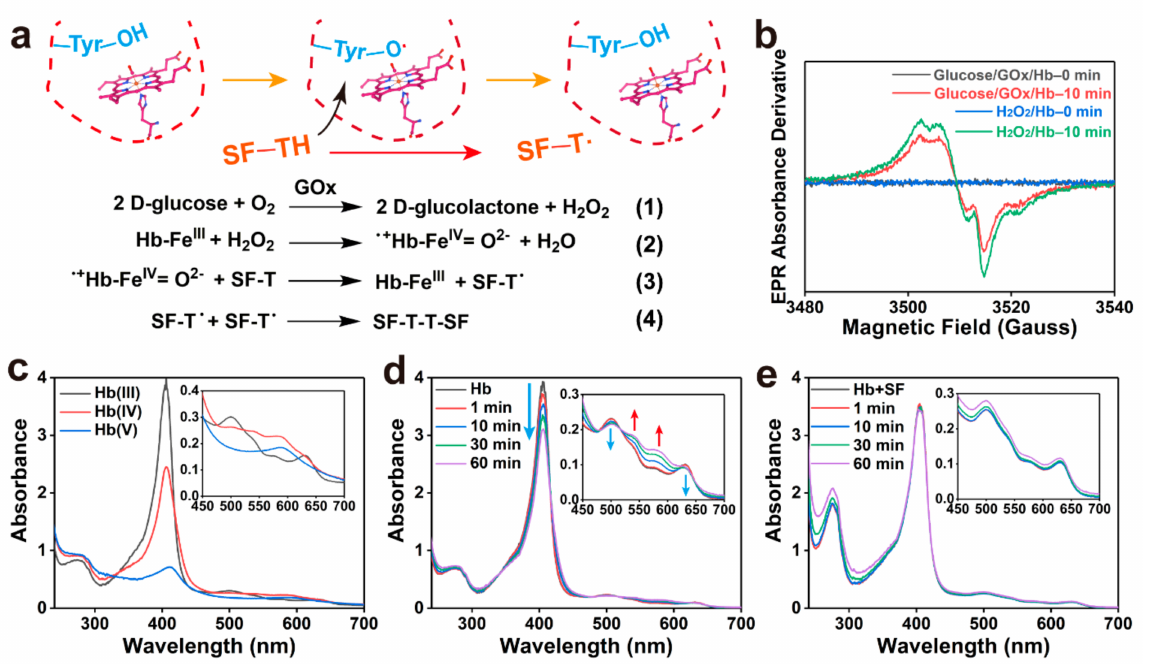
Figure 4. Mechanism of Hb-mediated crosslinking and SF as a protective antioxidant. ( a ) Mechanism of free radical transfer during gelation. ( b ) The EPR measurements confirmed the presence of tyrosyl radical. ( c ) Different states of Hb oxidation in the presence of H 2 O 2 within 12 h. ( d ) The states of Hb oxidation without the addition of SF in 1 h (glucose: 0.75 mg mL − 1 , GOx: 3.33 mu mL − 1 , Hb: 0.5 mg mL − 1 ). ( e ) The states of Hb oxidation with the addition of SF (1 mg mL − 1 ) in 1